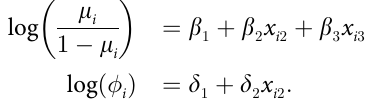
Table 7. Null rejection rates (%), H